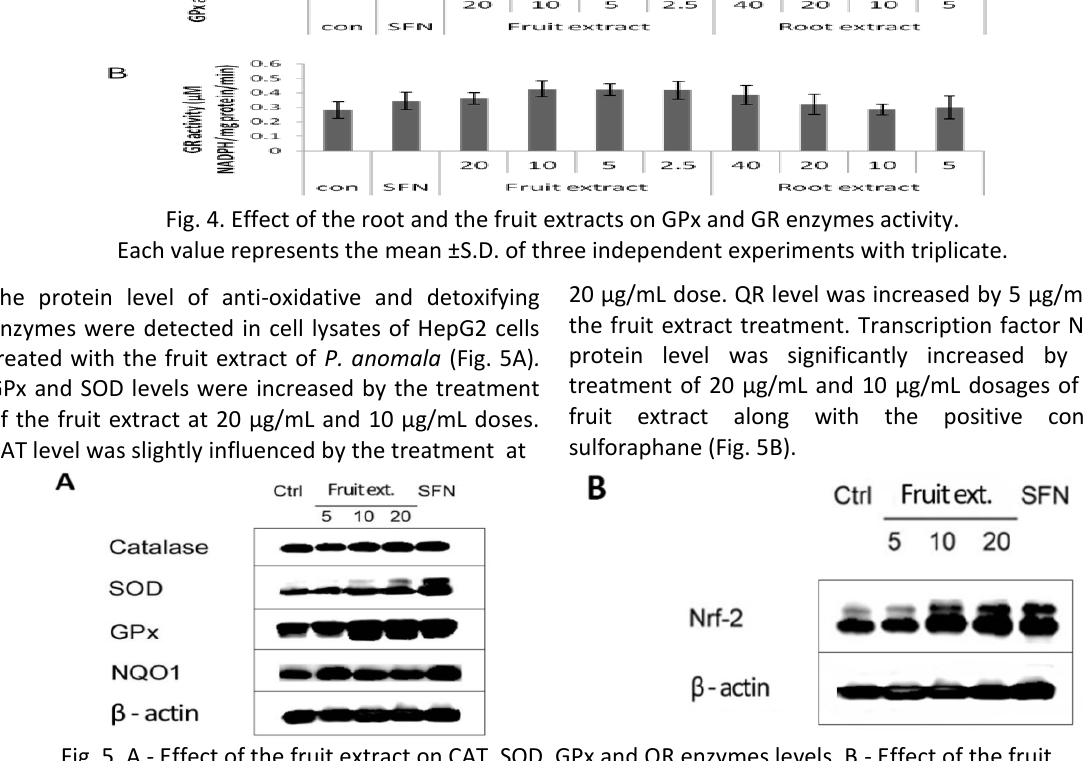
Fig. 5. A - Effect of the fruit extract on CAT, SOD, GPx and QR enzymes levels. B - Effect of the fruit extract on Nrf-2 protein level. The data represents the three independent